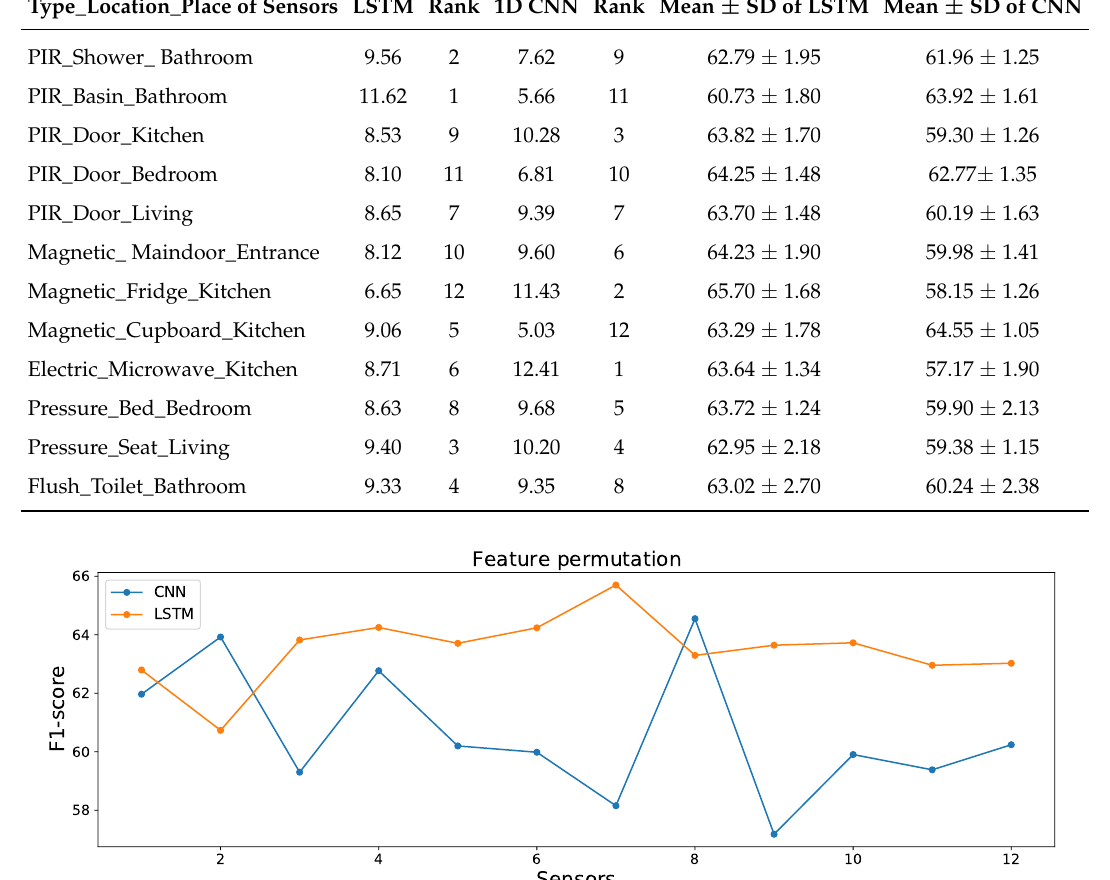
Figure 11. Results of mean F1-score for feature permutation of 12 sensors with N = 12 runs from Ordonez Home